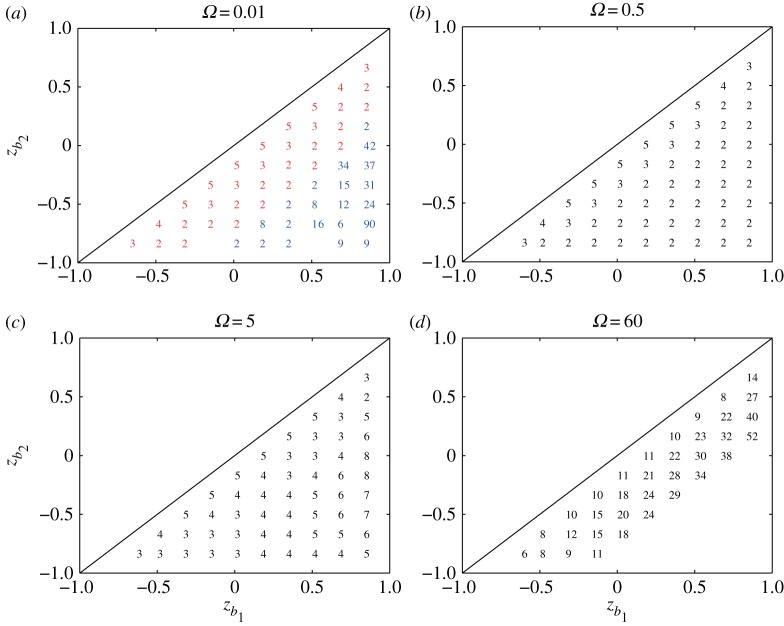
Stability diagrams showing the most unstable mode mmax for the vortex strip whose boundaries are located at zkb1 and zkb2 on the rotating sphere with the angular speed (a) Ω=0.01, (b) Ω=0.5, (c) Ω=5 and (d) Ω=60. The continuous vorticity distribution corresponding to the solid body rotation is approximated by M=95 band boundaries. The vorticity constants are given by ωN=ωS=1. In (a), the modes coloured with blue correspond to small associated growth rates and the modes in the remaining region are coloured with red.